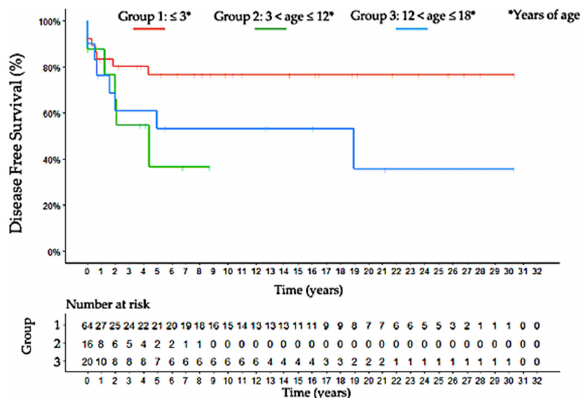
Figure 5. Kaplan-Meier curve estimates for disease-free survival according to each age-group; group 1: ≤ 3 years of age; group 2: 3 < age ≤ 12 years of age; group 3: 12 < age ≤ 18 years of age.